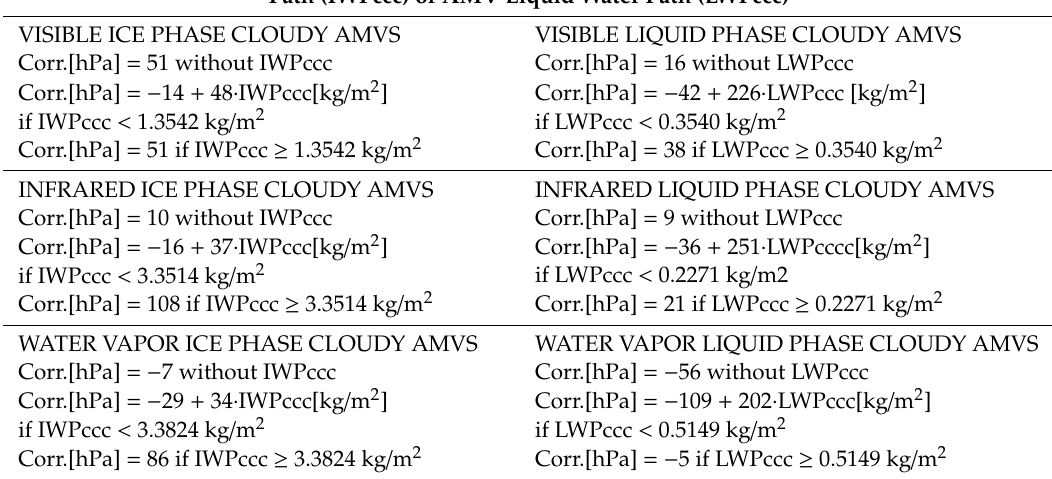
Figure 8. Graphs relating for MSG satellites the di ff erence between the AMV pressure level calculated with CCC method and the AMV best fit pressure level (in 10 3 hPa) in red, the NBIAS in yellow and the NRMSVD in blue (both dimensionless), with the AMV ice / liquid water path (in kg / m 2 ), for ice visible AMVs ( a ), ice infrared AMVs ( b ), ice water vapor AMVs ( c ), liquid visible AMVs ( d ), liquid infrared AMVs ( e ), and liquid water vapor AMVs ( f ). 12:00 UTC Cloudy AMVs for MSG-2 satellite for July 2010–June 2011 in the European and Mediterranean region used for the tuning. NBIAS and NRMSVD parameters used as defined in Appendix A. Table 2. Correction for the AMV pressure (in hPa), based on the AMV Ice water path (IWPccc) or AMV Liquid water path (LWPccc) values (in kg / m 2 ), for MSG satellite series. Correction for the AMV Pressure (in hPa) for MSG Satellite Series, Based on the AMV Ice Water Path (IWPccc) or AMV Liquid Water Path (LWPccc)